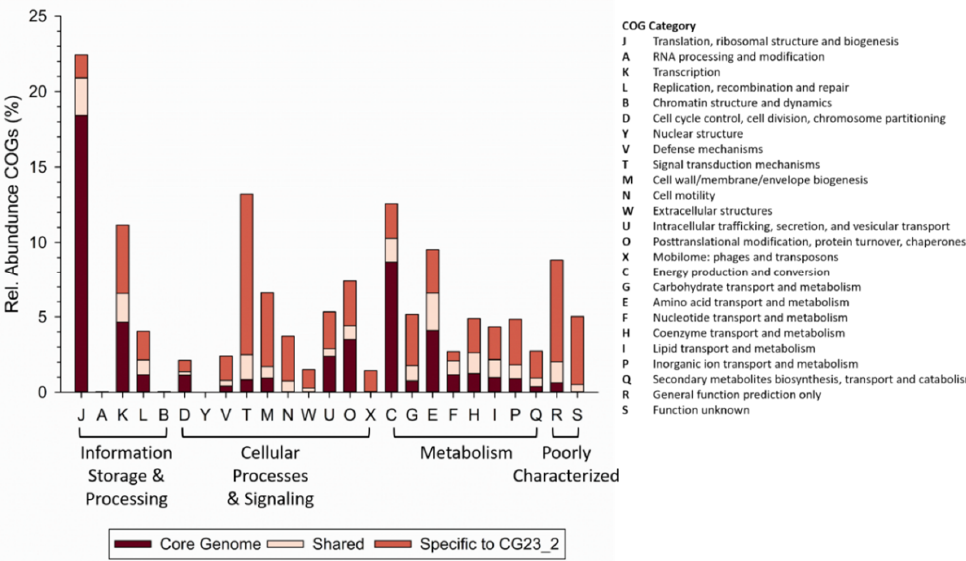
Figure 3. Relative abundance of functional classification of annotated protein coding genes normalized to the total number of protein coding genes for the core genome, shared between Janthinobacterium sp. CG23_2 and n ≥ 2 species/strains, and species-specific to Janthinobacterium sp. CG23_2. Protein coding genes lacking specific functional assignments were excluded. COGs: clusters of orthologous groups.